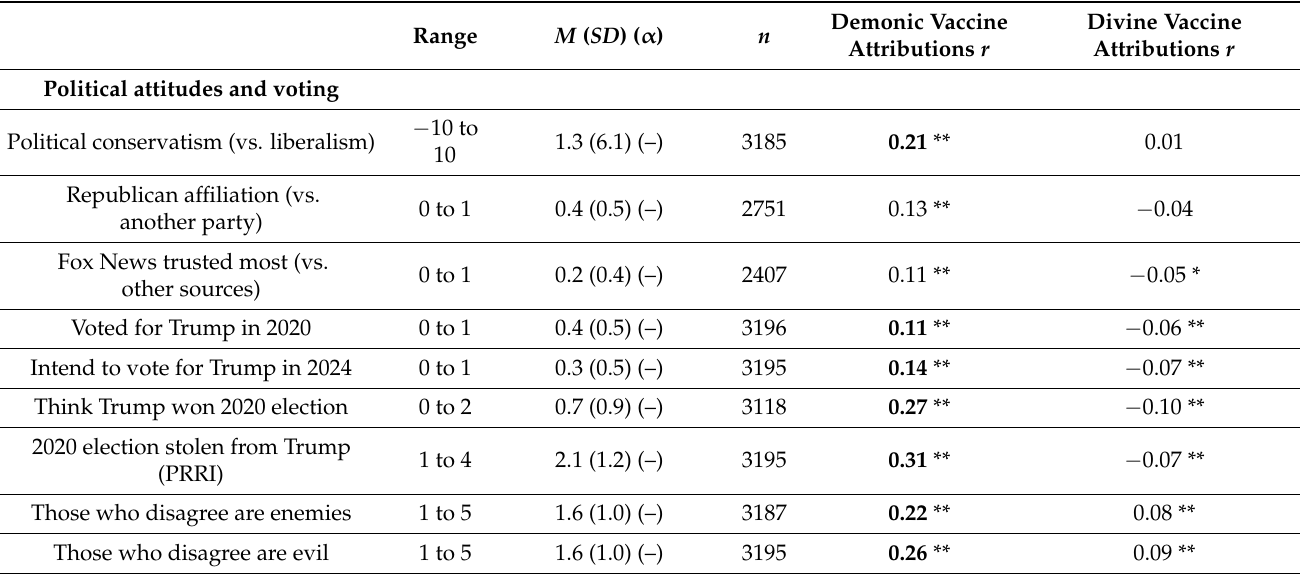
Table 6. Political Variables: Descriptive Statistics and Correlations with Demonic and Divine Vaccine Attributions.